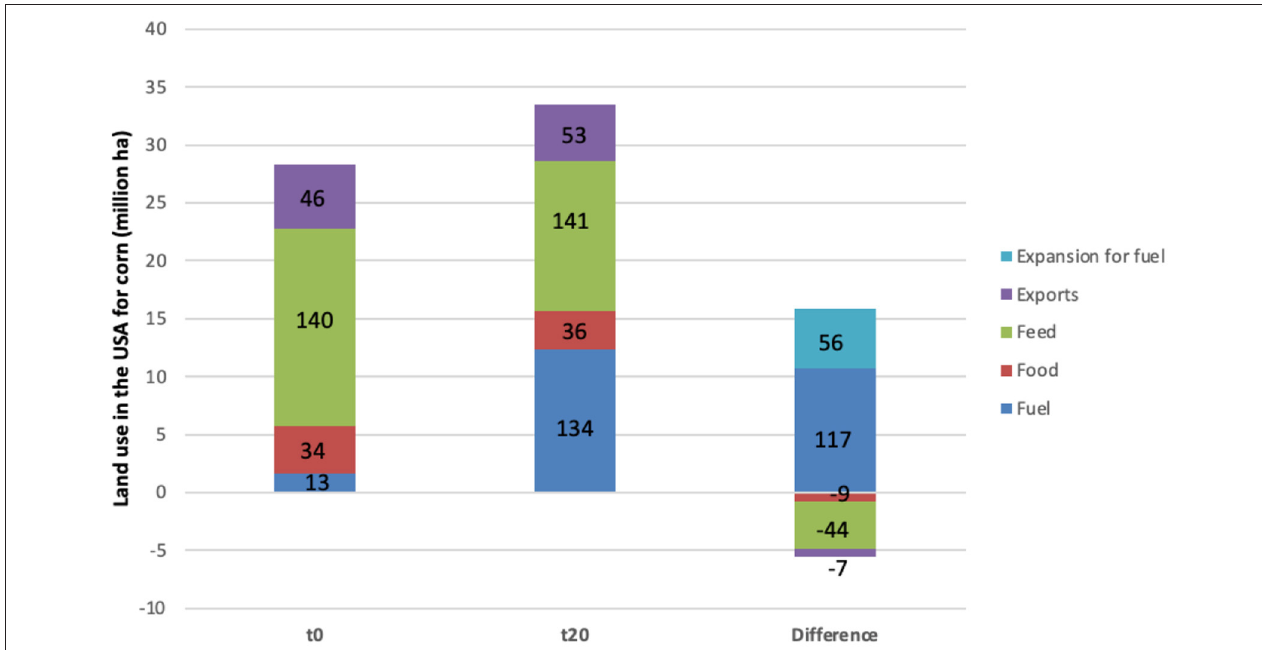
FIGURE 2 | Sources of corn supply for ethanol at the beginning and end of the 20-year period: diversion form other uses and land expansion (area and volume of production—the figures on the bars refer to the volume of production in Mt). Negative values refer to land (and associated production) coming from diversion from other uses (60 Mt). In addition, land expansion for corn for ethanol by 5.2 Mha produced an additional 56 Mt.